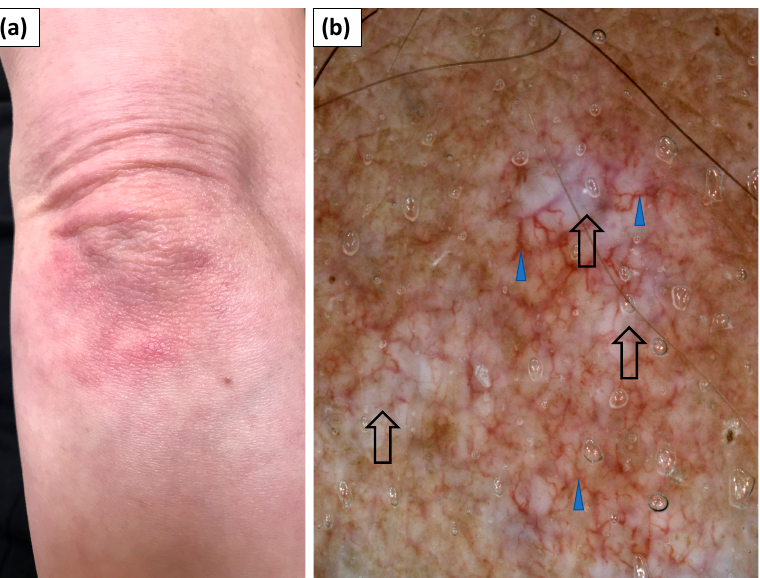
Figure 4. ( a ) Clinical presentation of Gottron’s sign over the elbow. ( b ) Videodermoscopy of Got- tron’s sign showed irregularly distributed linear vessels with branches (blue arrowhead) and white structureless areas (black arrow).